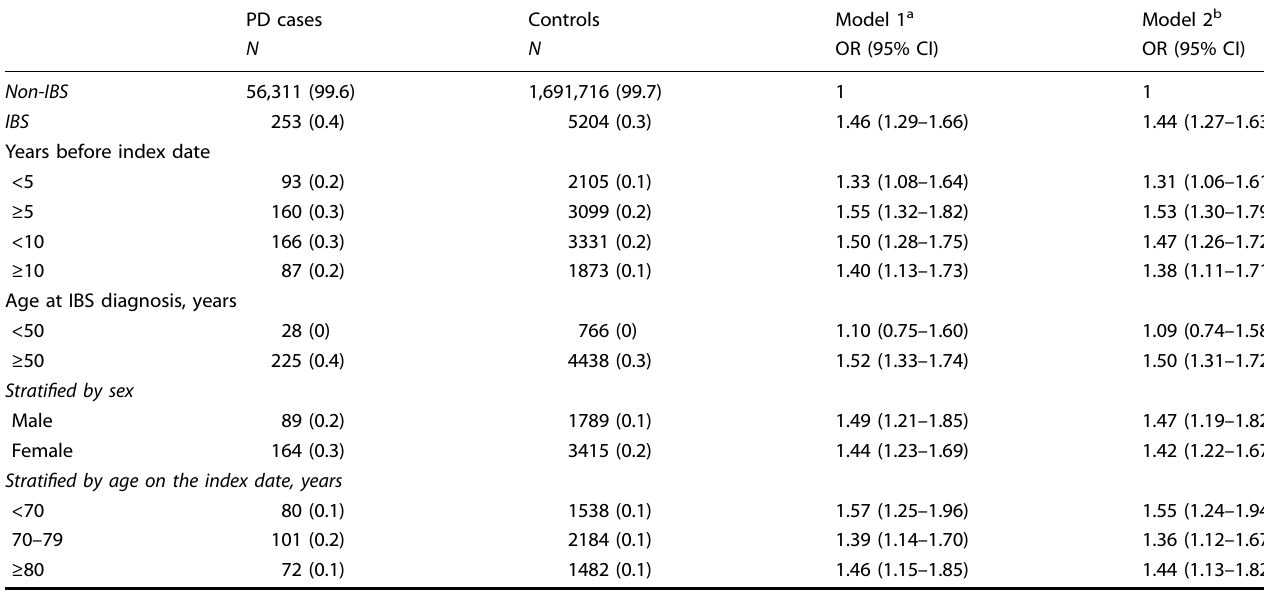
Table 2. Irritable bowel syndrome (IBS) diagnosis and risk of Parkinson ’ s disease (PD), nationwide case-control analysis. PD